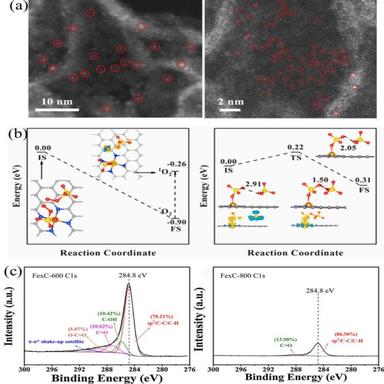
The key characterization of MOFs-derived SACs. (a) HAADF-STEM images of Co-ACs@NC and Co-SAs@NC Copyright 2019 Wiley. (b) DFTcalculated pathways for barrier-less 1 O2 production and PDS formation. Copyright 2022 Elsevier. (c) C1s high-resolution spectra of FexC composites . Copyright 2020 Elsevier.